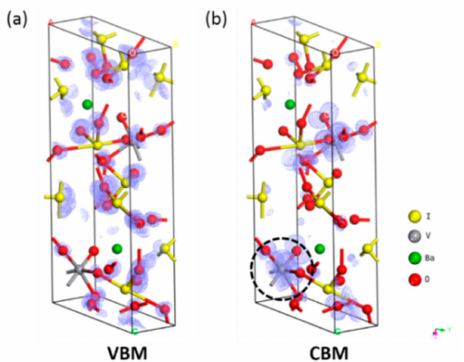
Figure 5. The wavefunction isosurface plots at ( a ) the VBM and ( b ) the CBM of BaVO(IO 3 ) 5